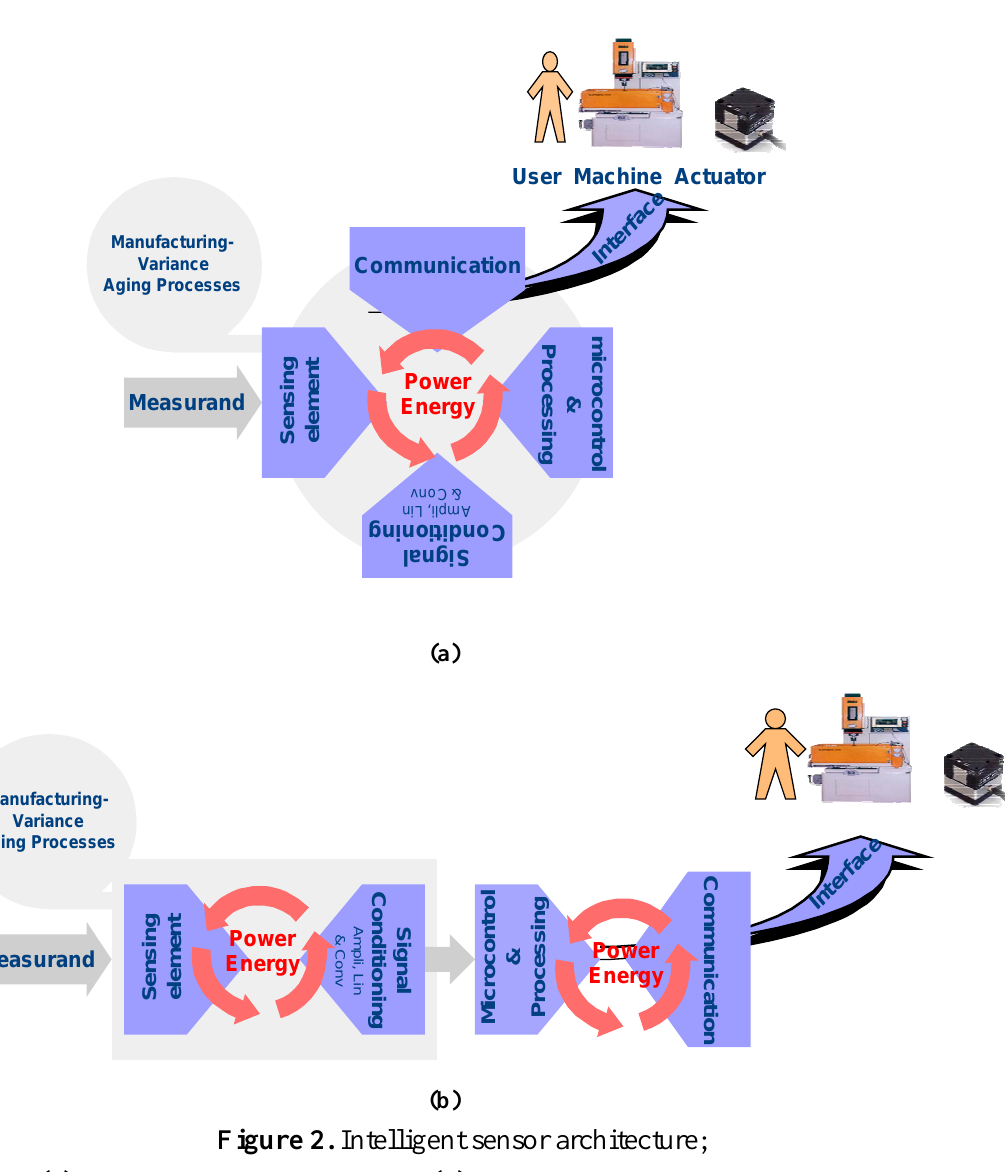
Figure 2. Intelligent sensor architecture; (a) Integrated intelligent sensor, (b) Semi-integrated intelligent